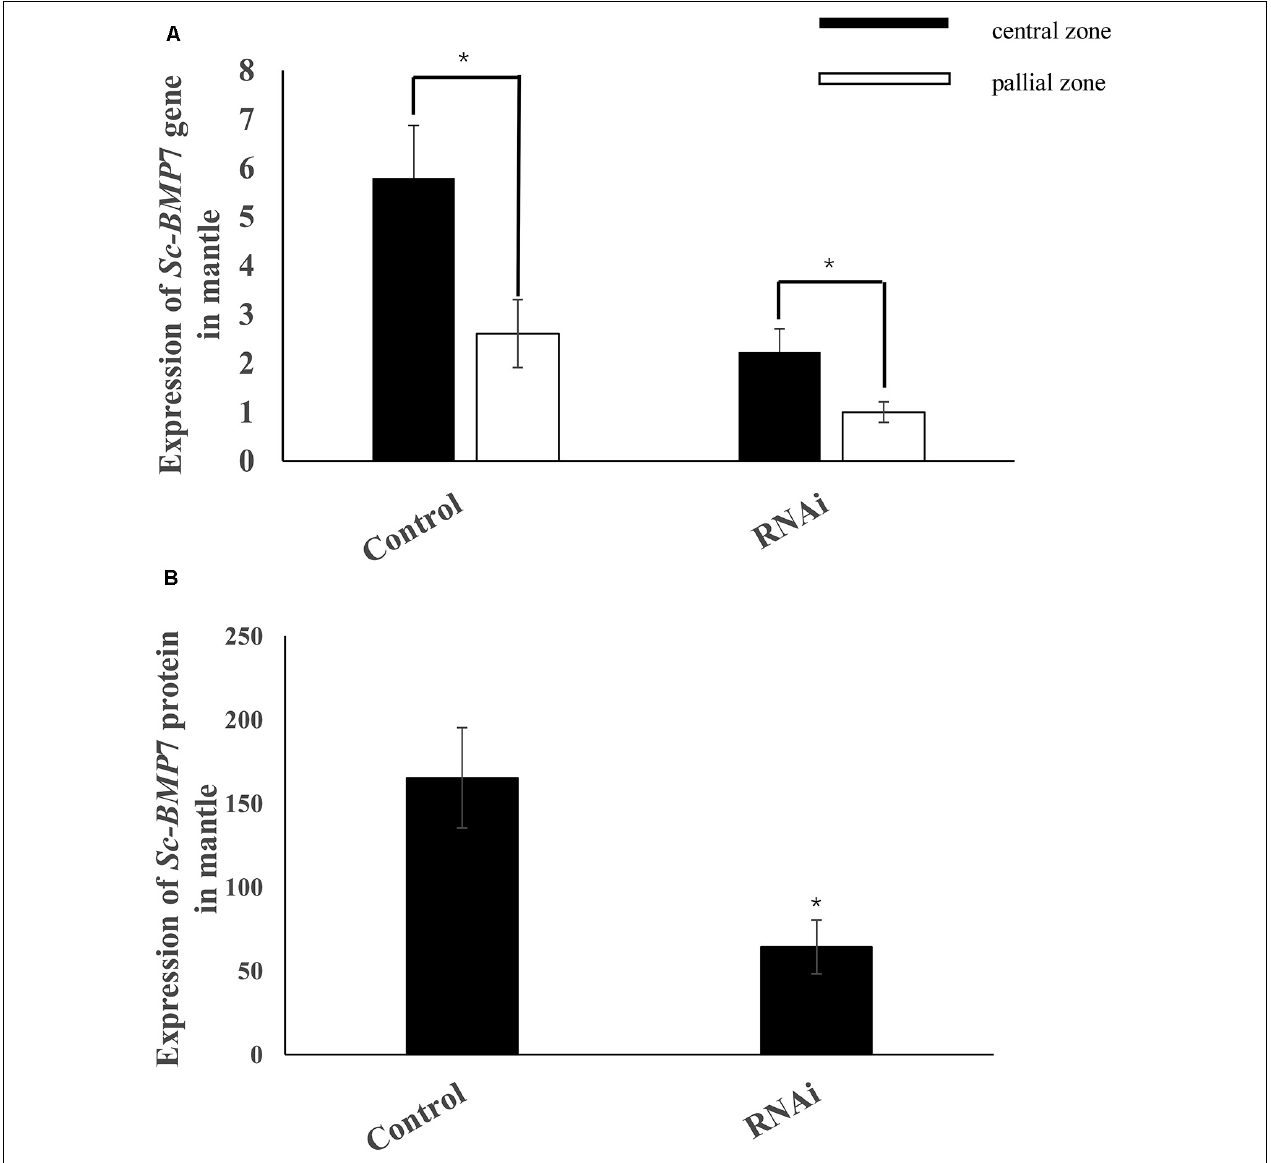
Table 2 . The phylogenetic tree, constructed using the neighbor- joining method, showed that BMP7 protein could be divided into two groups ( Figure 1B ), one containing all shellfish, and another comprising mammals, reptiles, and fish. M. meretrix BMP7 was firstly clustered with Sc-BMP7 in the former